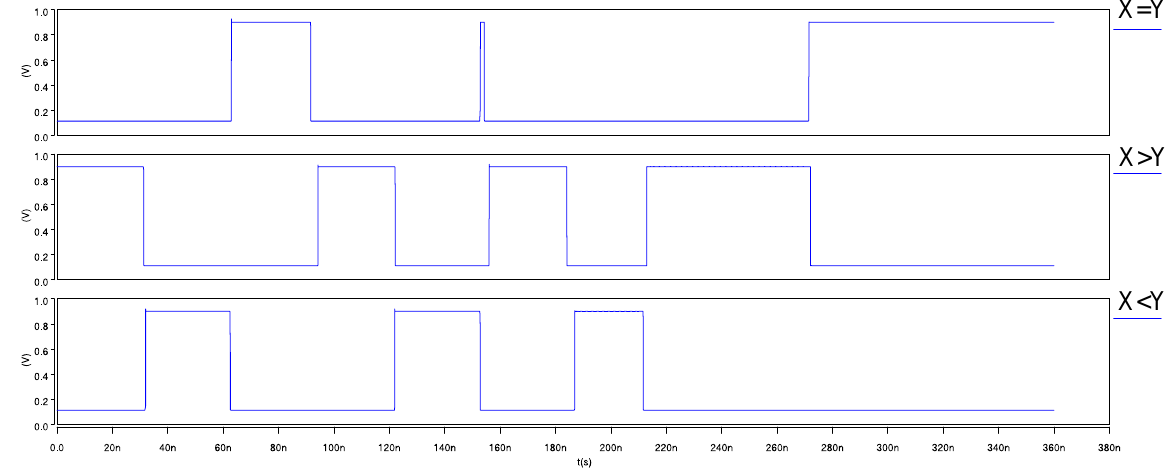
Figure 18. Transient response of 2-trit CNTFET-RRAM ternary comparator